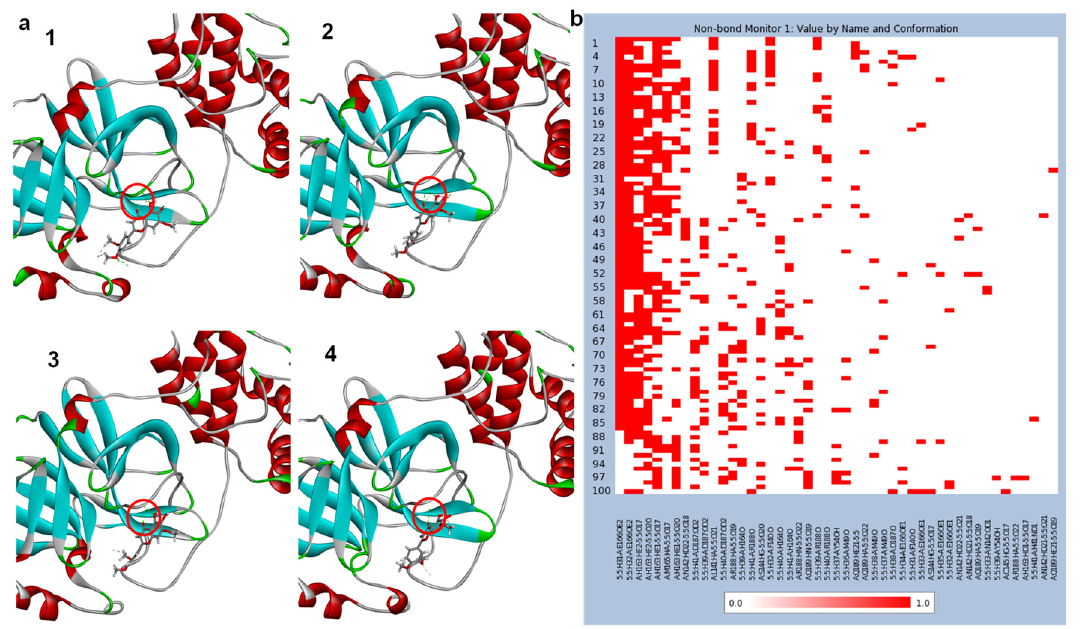
Figure 7. ( a ). Captured pictures from the MD-simulation video (red circle represents the main binding sites). ( b ). The heat map of binding sites between compound 5 with 2019-nCoV protease.